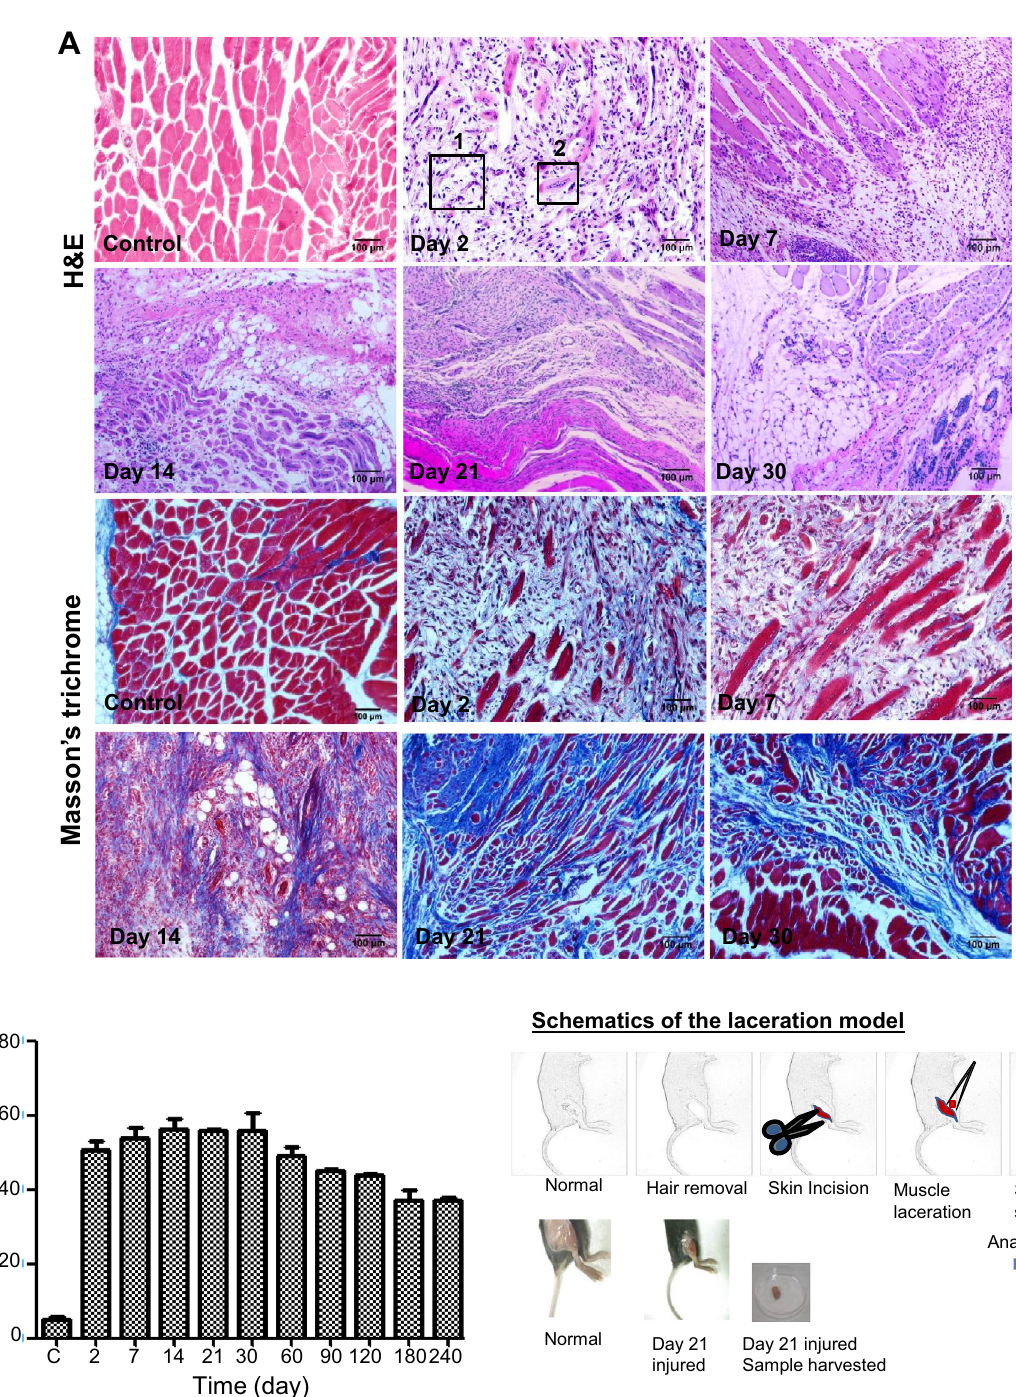
Figure 1. Pathology of lacerated skeletal muscle. ( A ) Histological analysis of gastrocnemius muscle post injury at different time intervals. H&E staining shows the trend of myofiber regeneration and cell infiltration. Box1— infiltrated immune cells; Box2—dedifferentiated muscle fibres ( top panel ). Masson’s trichrome staining of the sections. Results reveal heavy deposition of collagen indicated by the blue stain ( bottom panel ). ( B ) The collagen proportionate area (CPA) was quantified on the basis of morphometric analyses of 21 fields (10× magnification) of each time point using the ImageJ software. Data were presented as mean ±